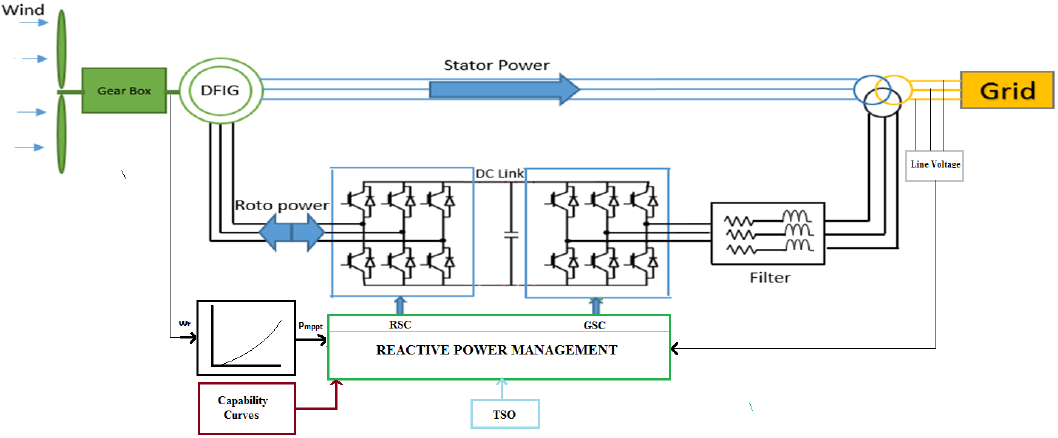
Figure 6 . The proposed Diagram of the wind energy conversion system